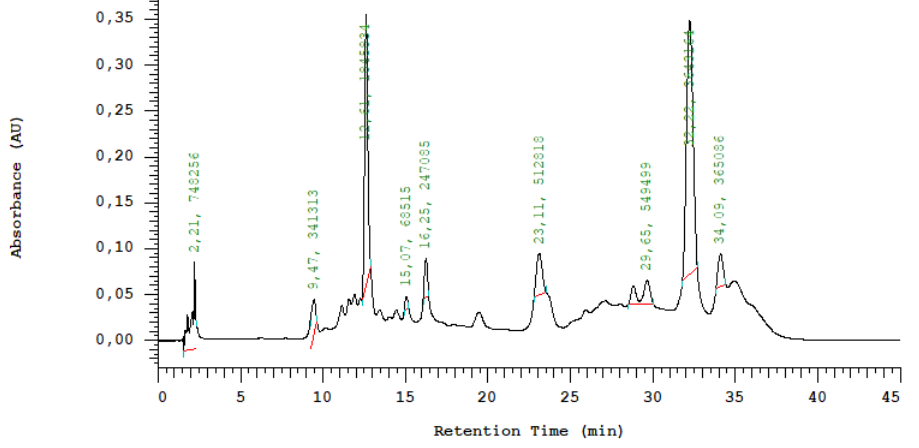
Figure 1. High- performance Liquid Chromatography (HPLC) analysis. Chromatogram of R. officinalis L. extract highlighted the presence of chlorogenic acid derivatives in its composition at the retention time of 12.61